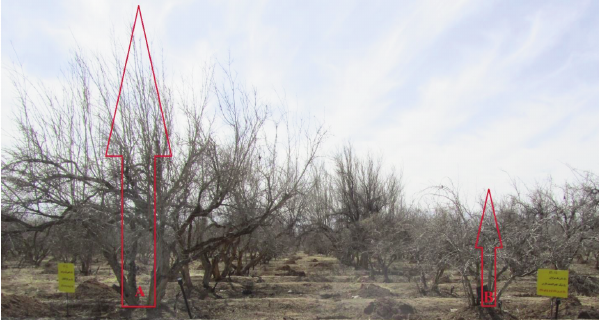
Fig. 2 ­ Comparison of tree height between a vigorous pomegra­ nate cultivar (A) and ‘Malas No. 1 Saravan’ (B), the most dwarf cultivar in the pomegranate genotypes studied.